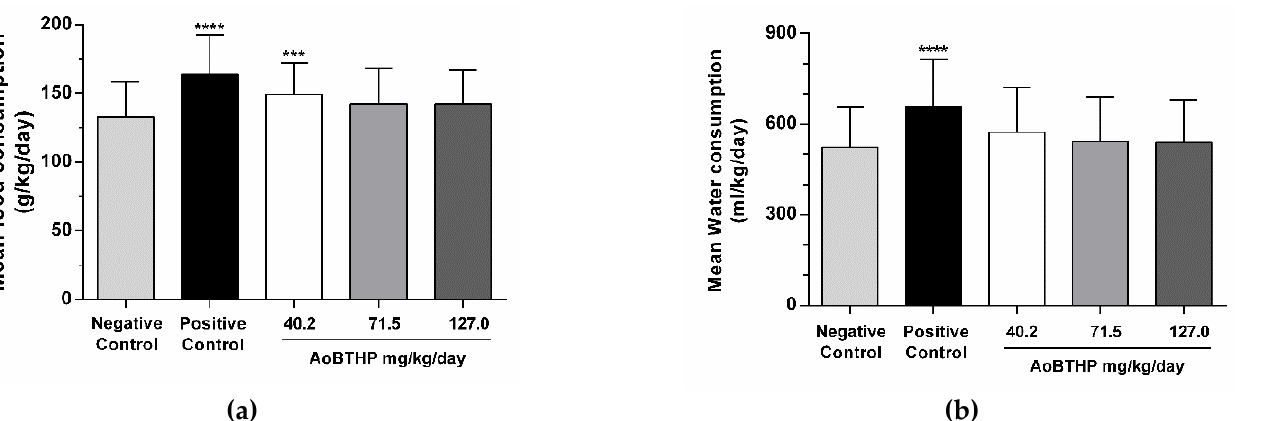
Figure 2. ( a ) Mean food consumption relative to average body weight per group of animals during the study (g/kg bw/day); ( b ) mean water consumption relative to average body weight per group of animals during the study (ml/kg bw/day). *** p < 0.001 vs. negative control; **** p < 0.0001 vs. negative control.